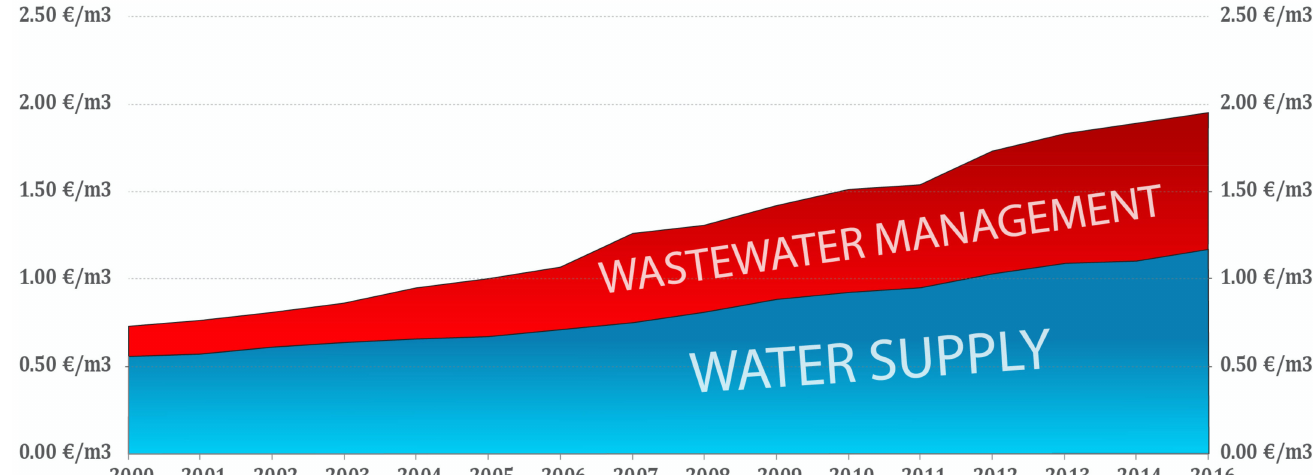
Figure 1. Evolution of the urban water supply (blue) and sanitation (red) price in Spain (euro/m 3 ). Source: Locken smart access solutions company, 2016